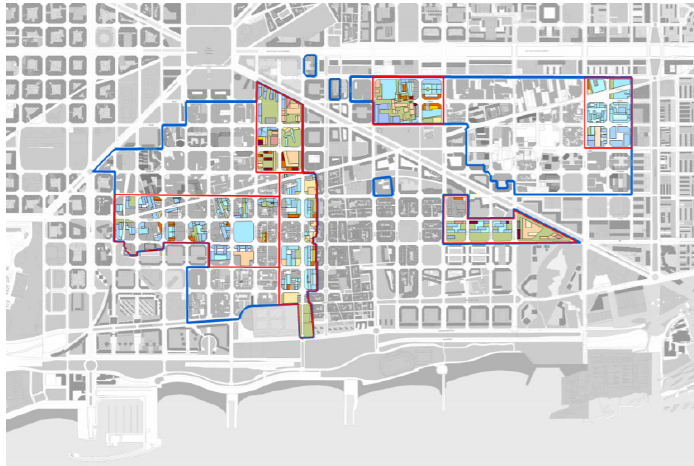
Figure 3. Development areas of the 22@ district (blue line: overall perimeter; red line: business and other non-residential areas) (source: Municipality of Barcelona) .